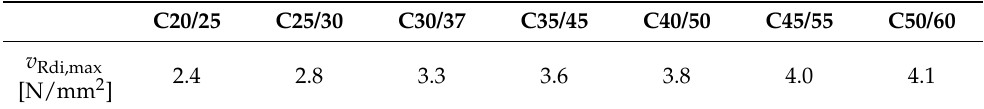
Table 2. Maximum shear resistance of lattice girders KTS and EQ for normal weight concrete according to the general technical approvals